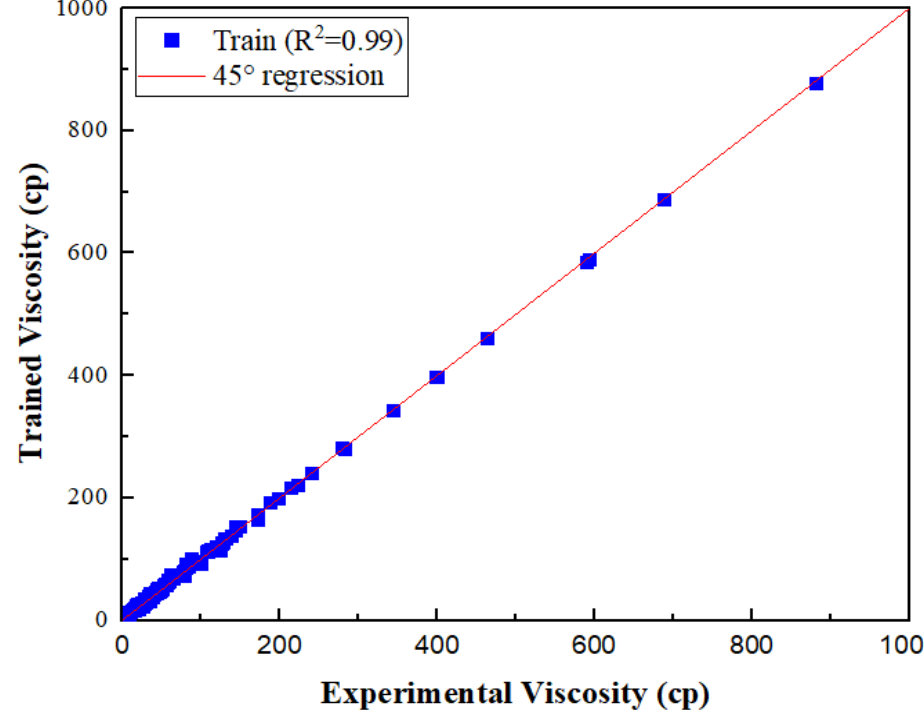
Figure 6. Regression plot of experimental versus trained viscosity.